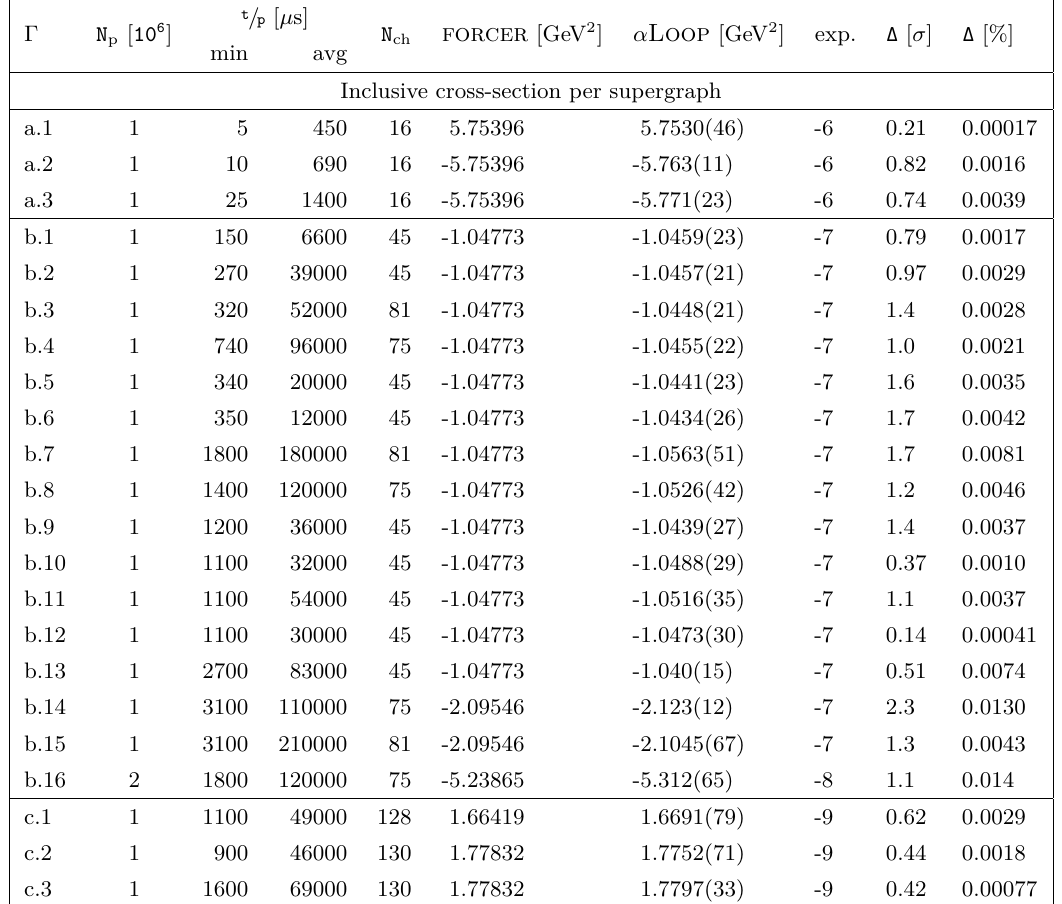
Table 3. Values of σ Γ (that is, the integrated sum of all interference diagrams arising from Γ , or inclusive cross-section per supergraph) for the supergraphs listed in 2 computed with α Loop for Q µ = (1 ,~ 0) and compared with benchmark results from forcer [48]. The table includes the total number of samples used for each integration, N , the number of integration channels N (see p ch section 5.4.1), the minimum and average per sample evaluation time of the integrand t / p , and the relative discrepancy with respect to the standard deviation ∆ [ σ ] and numerical result ∆ [%]